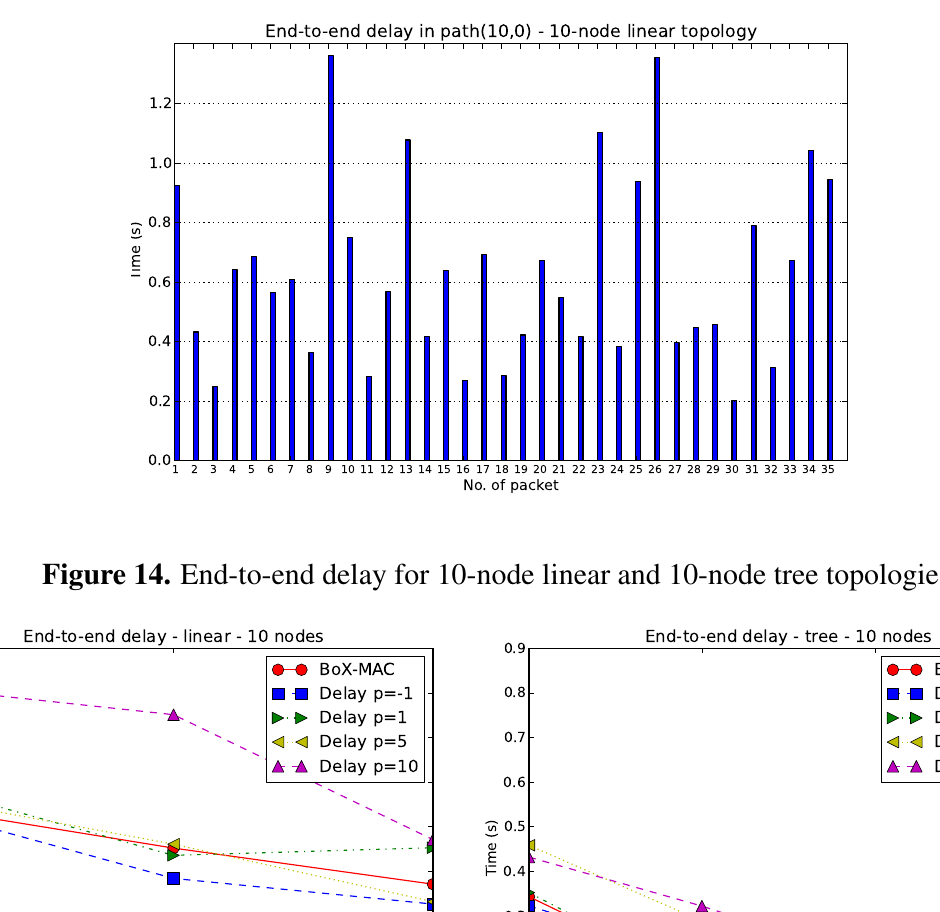
Figure 13. End-to-end delay between node 10 and 0 in a 10-node linear topology with DC = 30%.